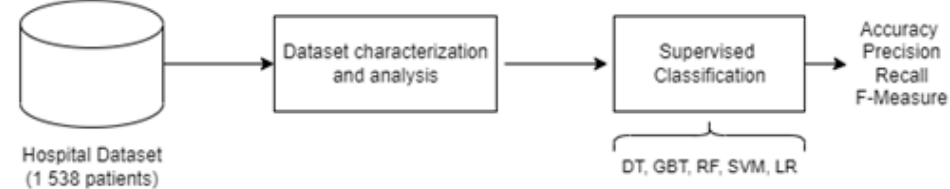
Figure 1. Overall flow of the proposed analysis from the patient’s point of view based on machine learning models.